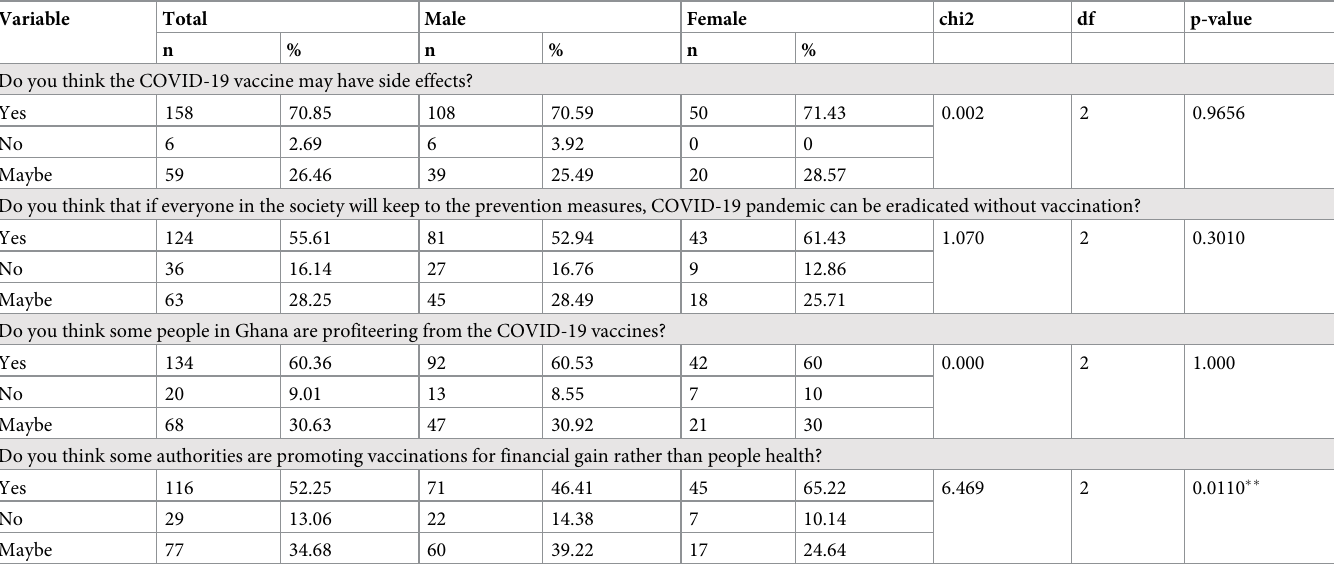
Table 4. Distribution of each perception item by gender difference.